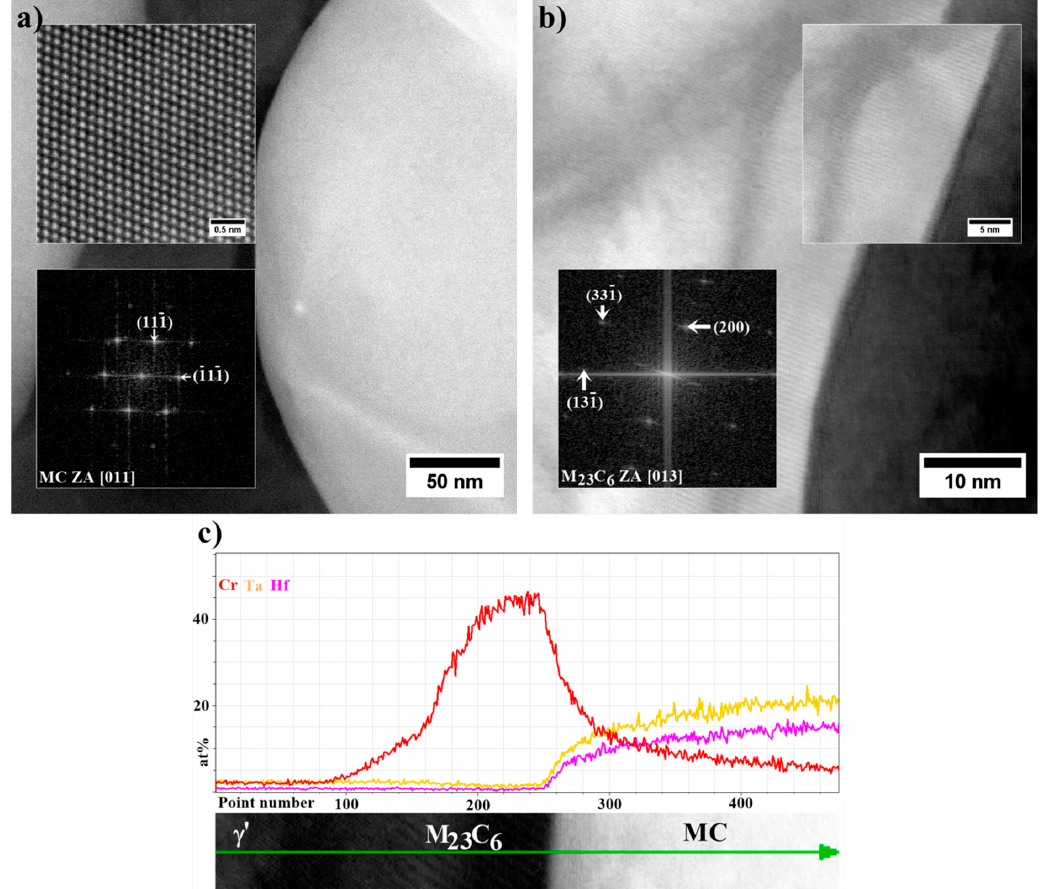
Figure 20. a ) atomic structure and FFT image of MC carbide (STEM-HAADF); b ) the